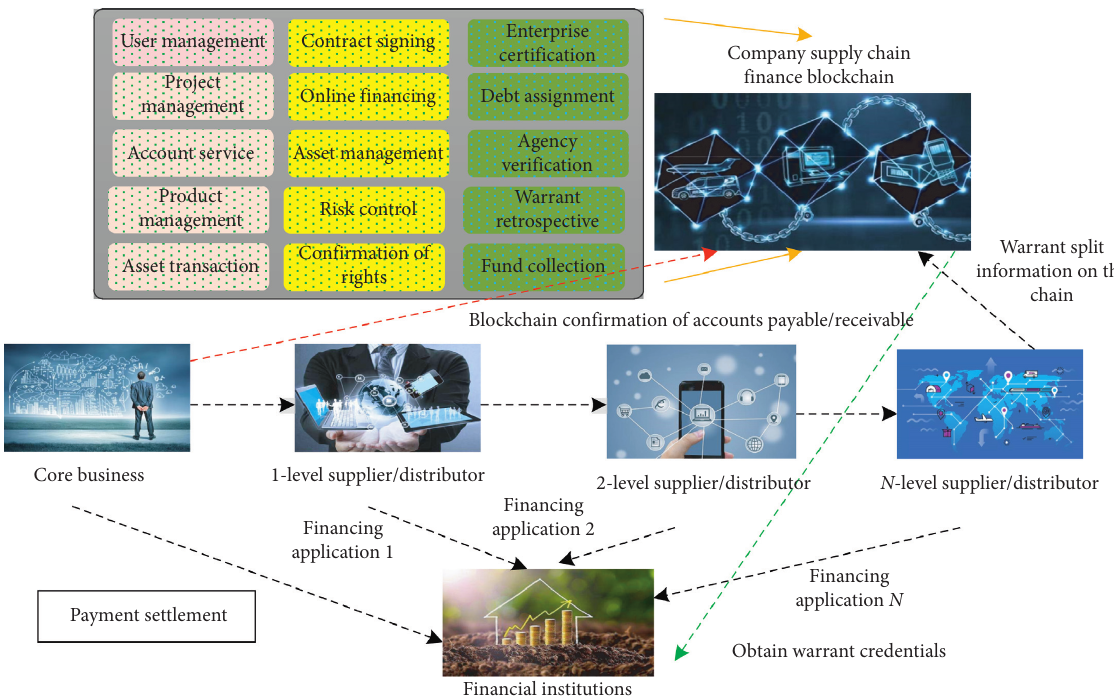
Figure 2: Supply chain finance financing platform architecture.